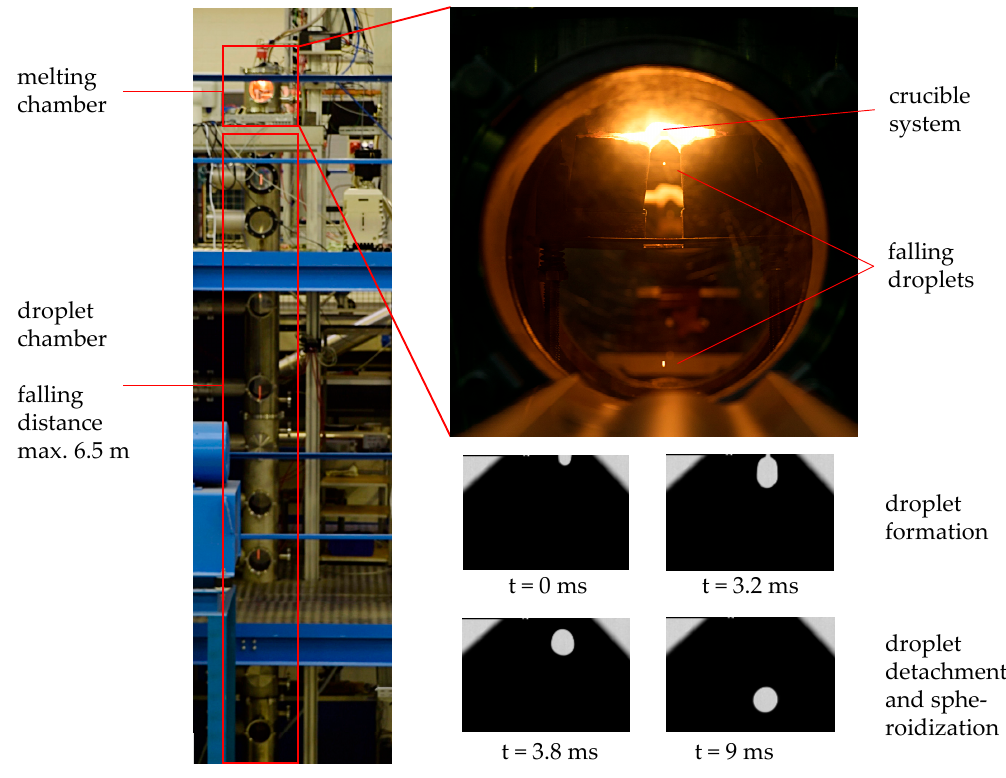
Figure 1. High-temperature drop-on-demand facility for spherical micro-sample synthesis.